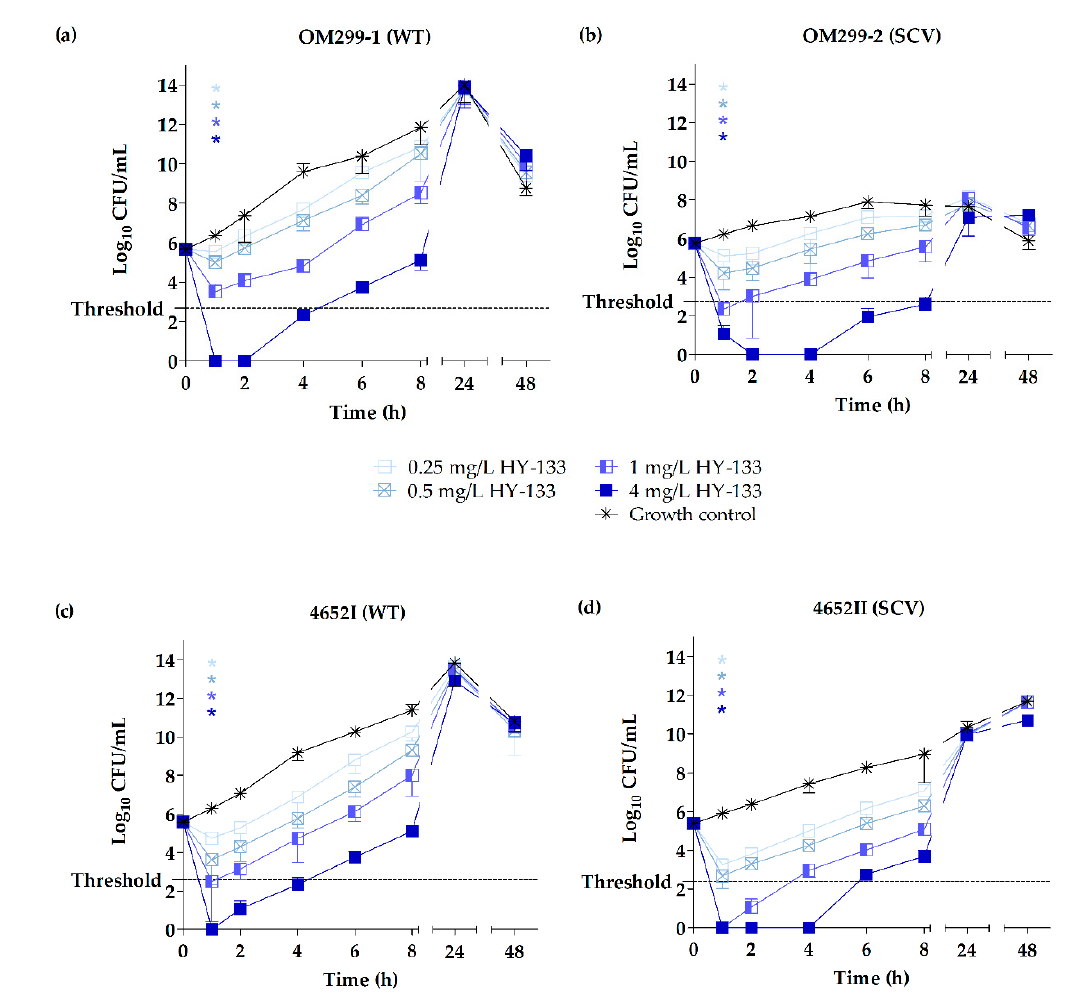
Figure 1. Time-kill curves of HY-133 shown by plots of mean values for the log 10 of the numbers of CFU/mL versus time for two representative clinical Staphylococcus aureus WTs ( a , c ) and corresponding SCVs ( b , d ) tested against HY-133. The threshold implicates a ≥ 3 − log 10 decrease in CFU/mL. Time-kill curves for each strain were performed in triplicate (mean ± standard deviation). Asterisks denote statistical difference of the respective concentration of HY-133 used (defined by matching colors) with respect to the untreated growth control at 1 h; p ≤ 0.001 by one-way ANOVA.